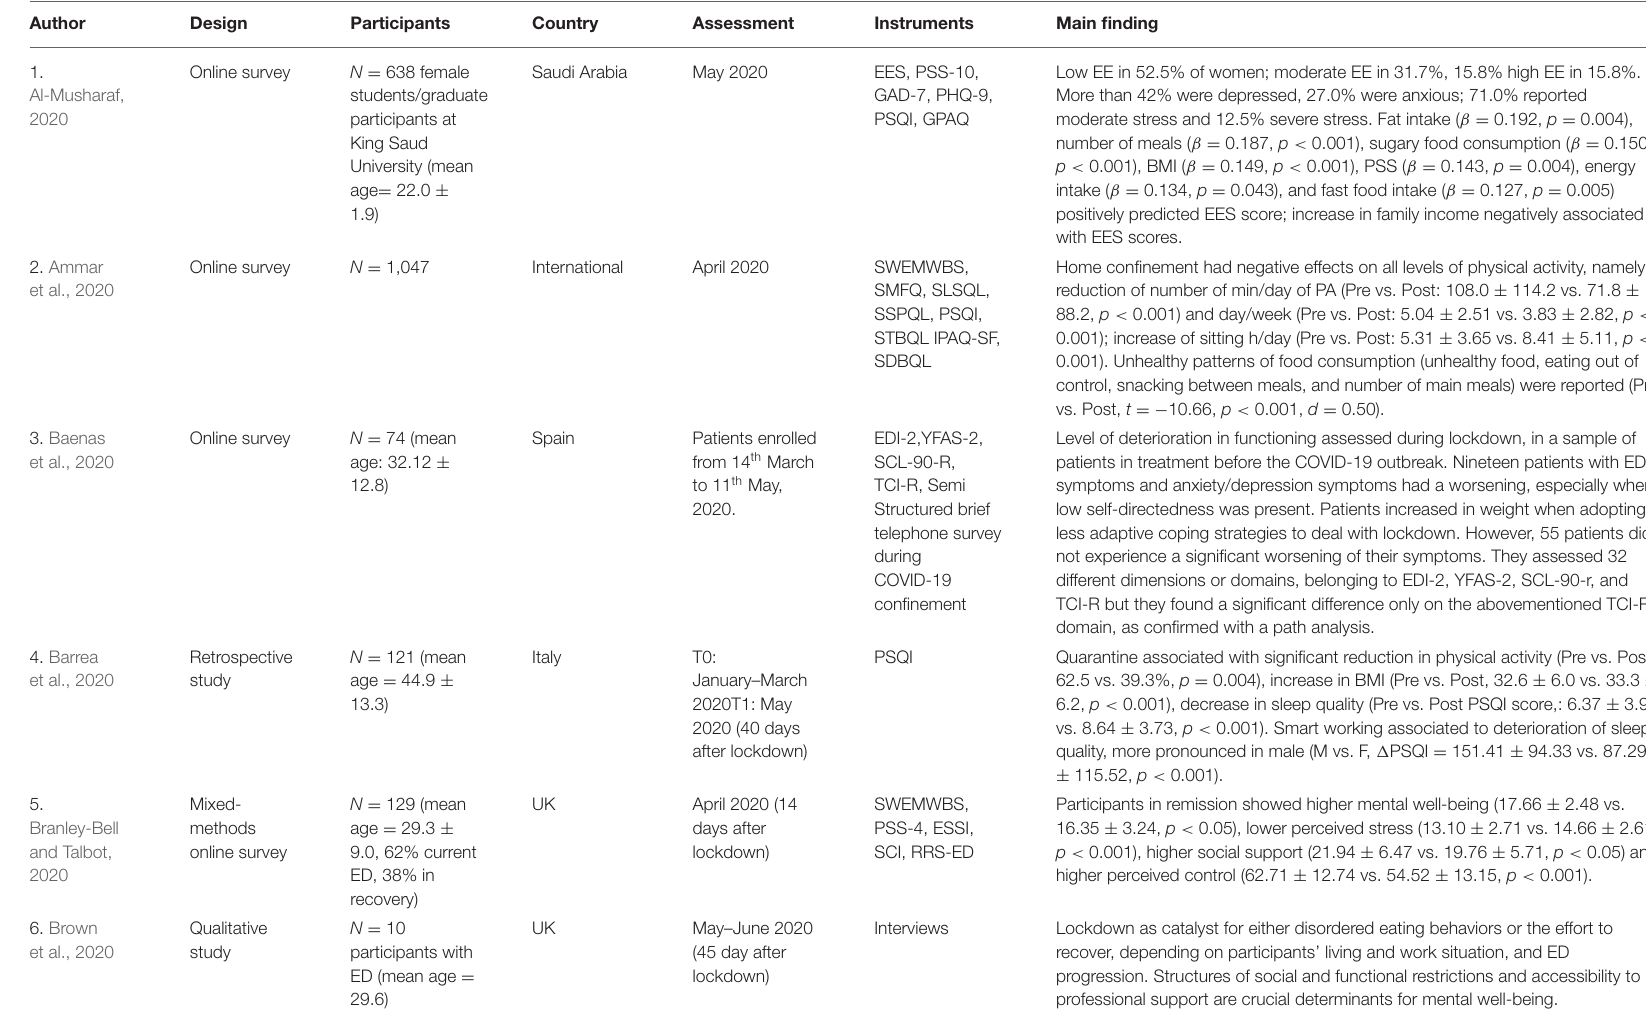
TABLE 2 | Studies on eating disorders spectrum during COVID-19